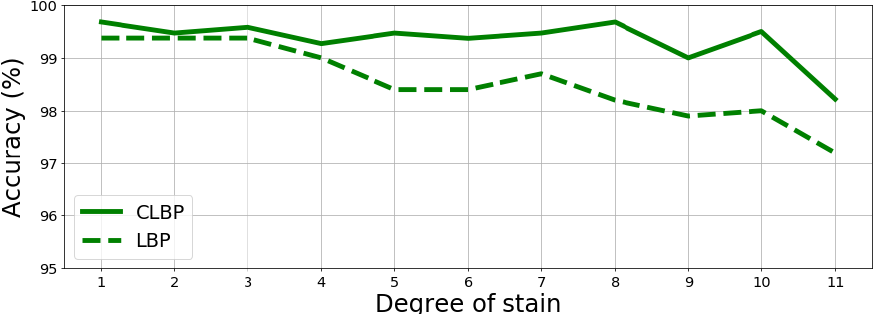
Figure 8. Accuracy of CLB and LBP VS degrees of stain